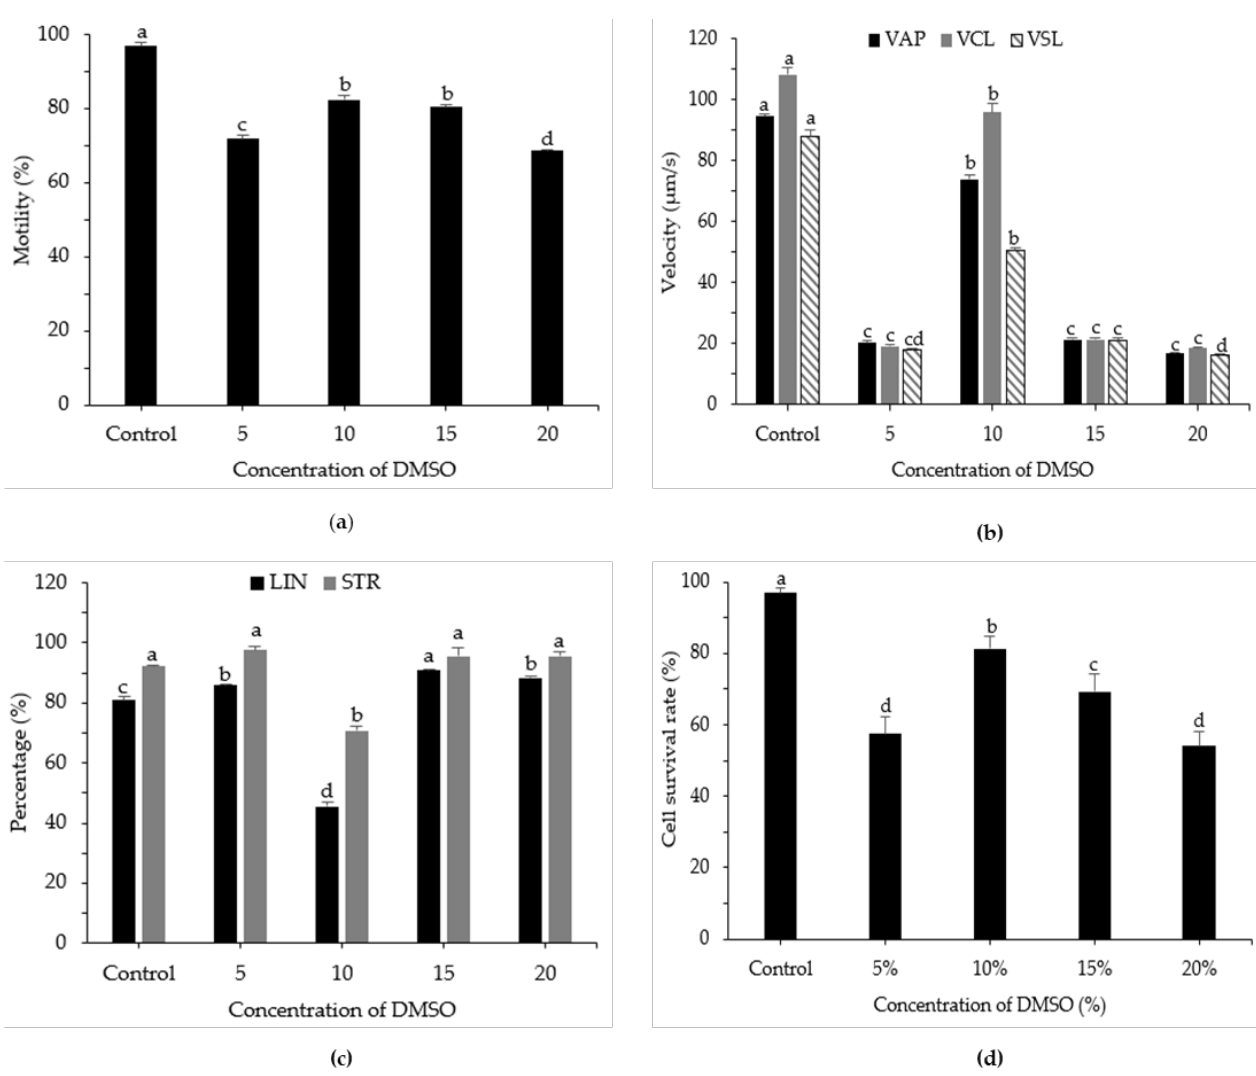
Figure 3. Computer-assisted sperm analysis of frozen and fresh sperm from roughscale sole, Clidoderma asperrimum , using various concentrations of DMSO with Stein’s solution as the diluent. ( a ) Motility (%), ( b ) average path velocity (VAP; µ m s − 1 ), curvilinear velocity (VCL; µ m s − 1 ), straight-line velocity (VSL; µ m s − 1 ), ( c ) linearity (LIN; %), straightness (STR; %), and ( d ) cell survival rate (%). Different lowercase letters indicate significant differences among concentrations of DMSO ( p < 0.05). Control, fresh